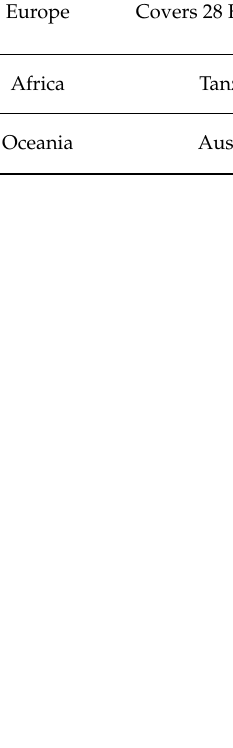
Table 2. Various agricultural residues used for mushroom